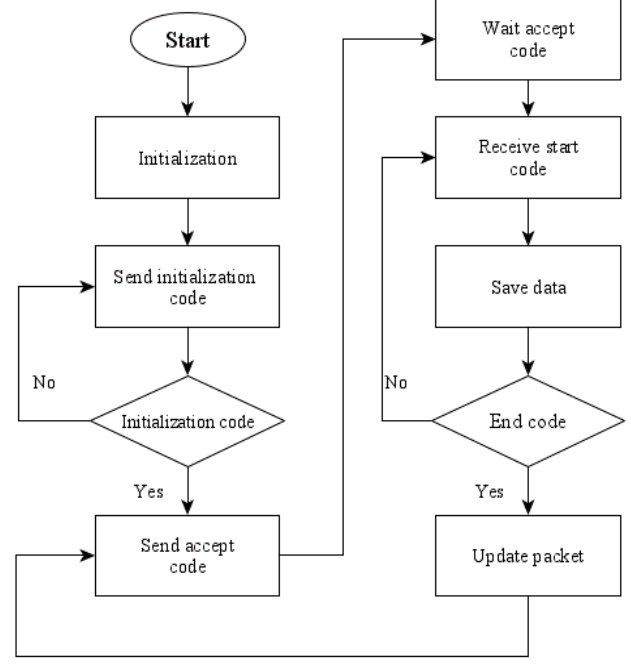
Figure 12. The flow chart of RS-232 communication protocol.